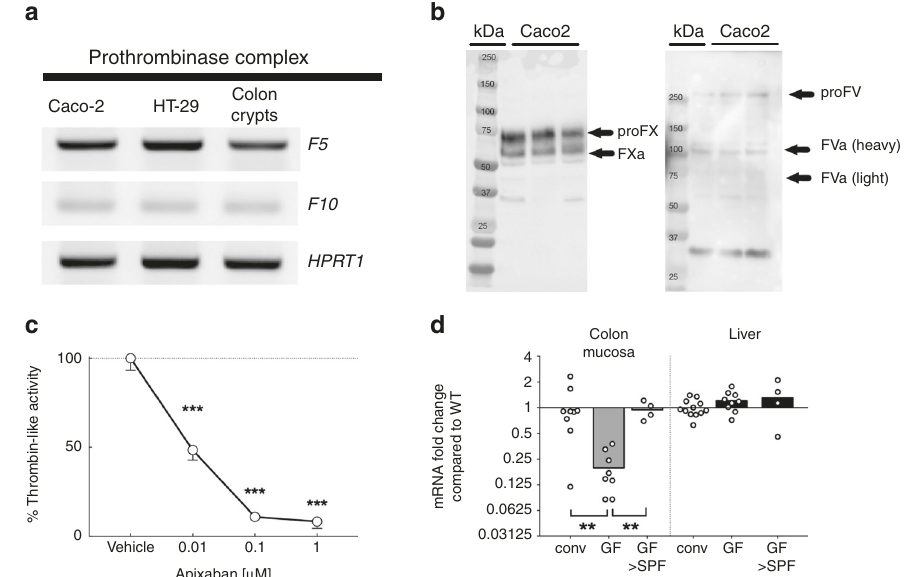
Fig. 2 Thrombin is activated by epithelial-prothrombinase complex and is regulated by commensal microbiota. a mRNA transcripts for the two genes of the prothrombinase complex (gene F5 and gene F10 ) were detected in two different human cancer cell lines (Caco-2 and HT-29) and isolated human colonic crypts. The same samples used in Fig. 1a to detect F2 transcripts were used to detect F5 and F10 transcripts in Caco-2 and HT-29. Representative blots from 3 independent experiments. b Western blots revealed the presence of Factor 10 (inactive, 74 kDa and active form 54 kDa, left blot) as well as Factor 5 (inactive, 300 kDa; active heavy chain 94 kDa and active light chain 74 kDa, right blot) in Caco-2 cell protein extract (left blot). Representative blots from 2 independent experiments. c Epithelial thrombin activity produced by Caco-2 was dose-dependently inhibited by the presence of the F10 inhibitor Apixaban during 24 h (0.01, 0.1 and 1 µ M). Activity assay was reproduced in 3 independent experiments. Data are presented as mean ± SEM. One-way ANOVA with Fisher ’ s LSD test *** P < 0.001 vs. vehicule group ( d ). Germ-free mice (GF, n = 5), germ-free recolonized with speci fi c-pathogen-free (SPF) cecal content (GF > SPF, n = 5) and conventionally-bred mice (CONV, n = 8) were sacri fi ced at 10 – 14 weeks old. Relative expression of F2 mRNA transcript (thrombin) was unchanged in germ-free mouse liver compared to conventionally-bred mouse liver and GF > SPF. In germ-free mouse, F2 mRNA was signi fi cantly reduced in colon mucosa compared to conventionally-bred mouse colon mucosa. GF recolonized with SPF microbiota had identical transcription of epithelial thrombin compared to conventional mice. One-way ANOVA with Fisher ’ s LSD test ** P < 0.01 vs. GF group. Data are represented as scatter plot with the mean